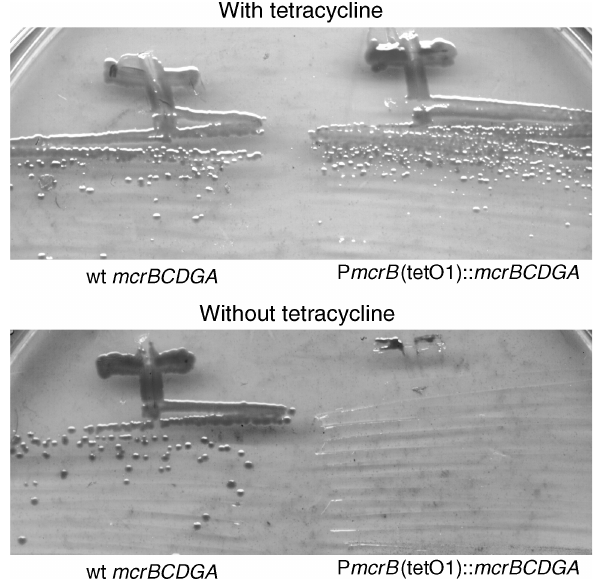
Figure 6. Essentiality of the mcr operon in Methanosarcina barkeri. WWM155 and WWM235 were streaked on HS-methanol agar in the presence (100 µg ml –1 ) or absence of tetracycline. Growth of the P mcrB (tetO1):: mcrBCDGA only in the presence of tetracycline indi- cates that the mcr operon is